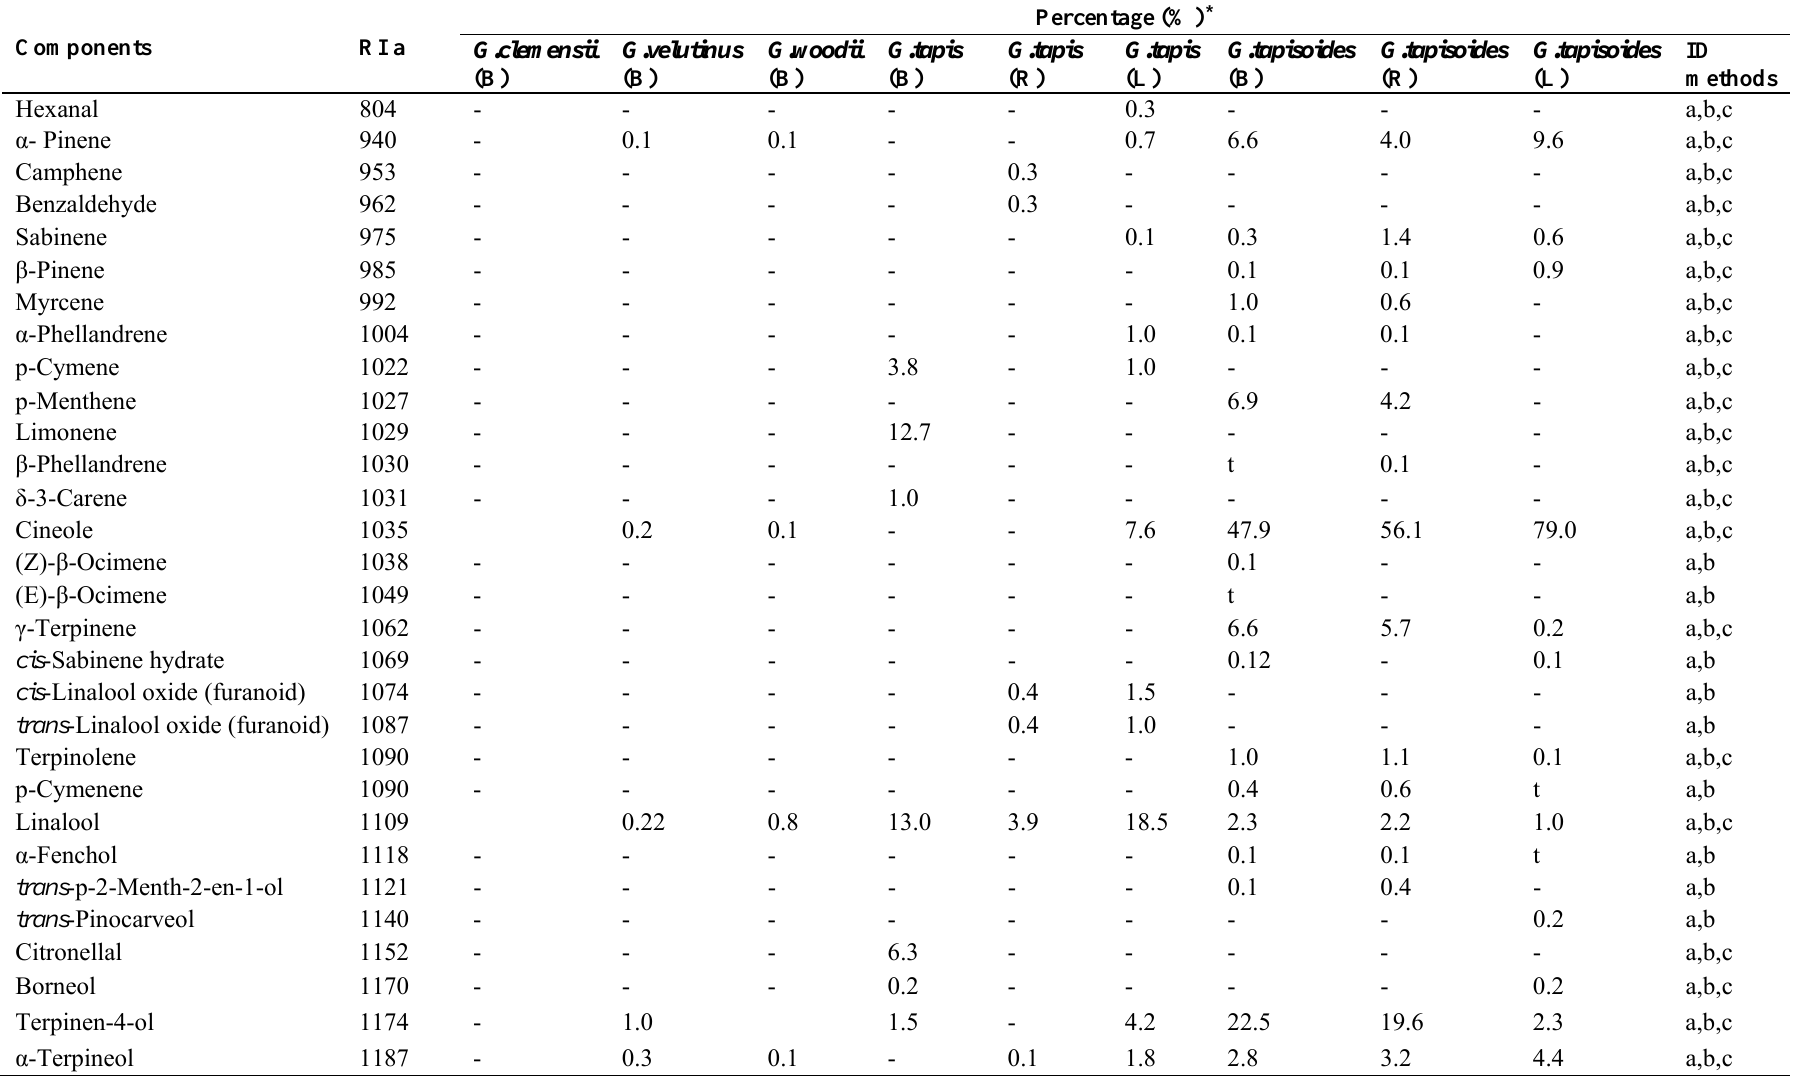
Table 2. Percentage composition of the essential oils of selected Goniothalamus